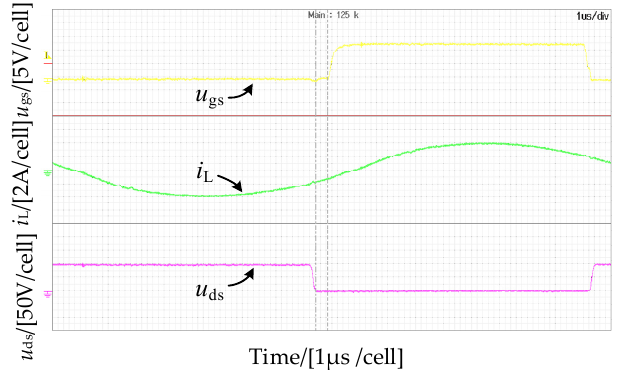
Figure 33. Bridge-arm A soft-switching waveform